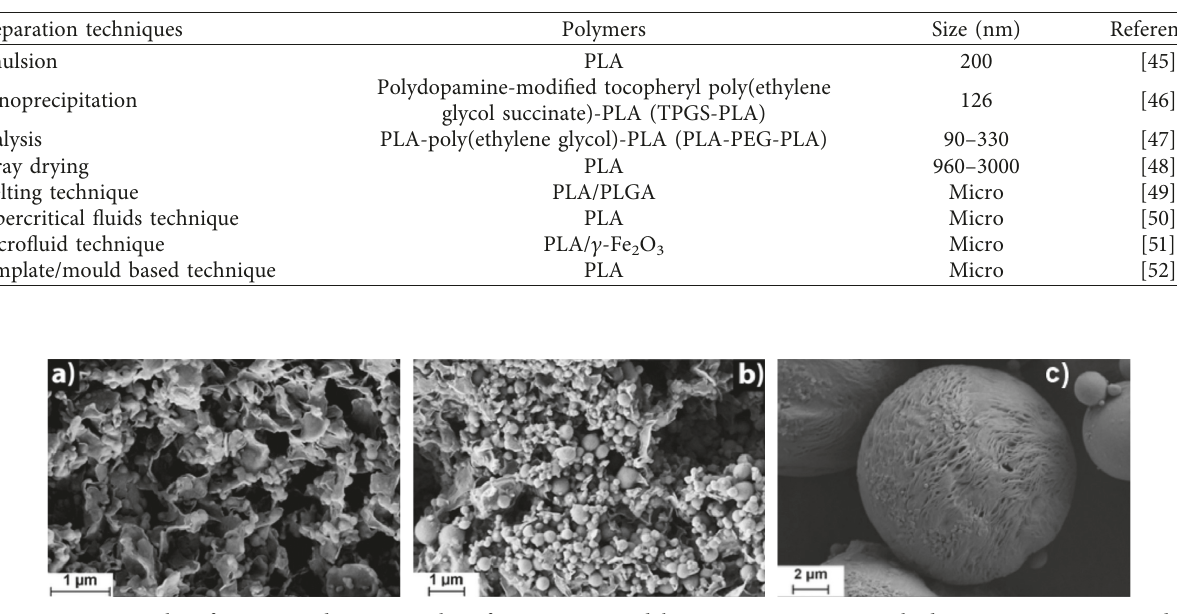
Figure 7: SEM micrographs: (a) lateral view of 3D filament-deposited scaffold reconstruction; (b) inner structure of the same scaffold; (c) colonisation of the 3D PCL scaffold in dynamic condition (scale bar 1mm); (d) high magnification showing the external cell monolayer (scale bar 1mm); (e) cells bridging the grooves (scale bar 100 μ m); (f) cell arrangement suggestive of a new vascular structure (scale bar 100 μ m); (g) spheroid of MC63 and human umbilical vein cells generated in dynamic condition (scale bar 50 μ m) (adapted with permission from ref. [38]). Table 1: Preparation of PLA base (bio)degradable polymeric nanomaterials.